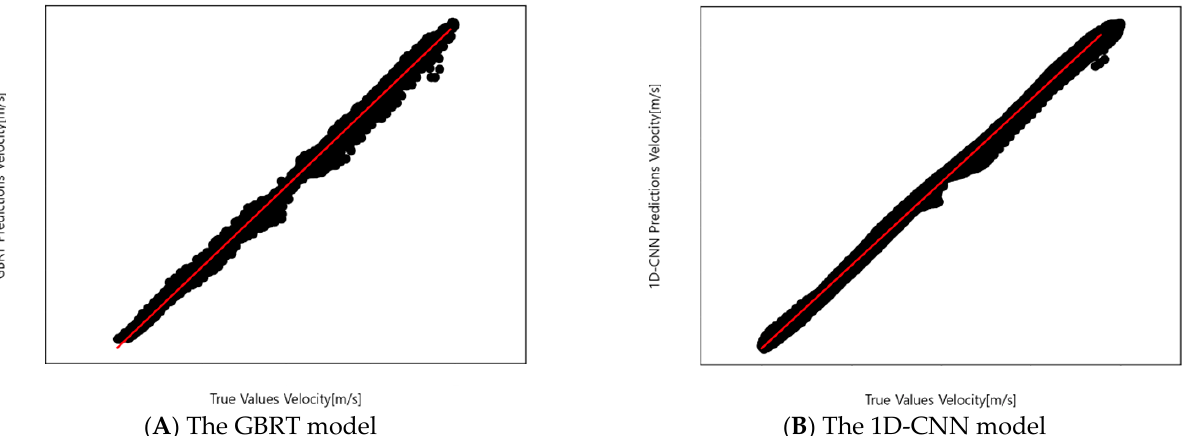
Figure 15. Chart comparing the actual and predicted values of the GBRT and 1D-CNN models based on base specification data.